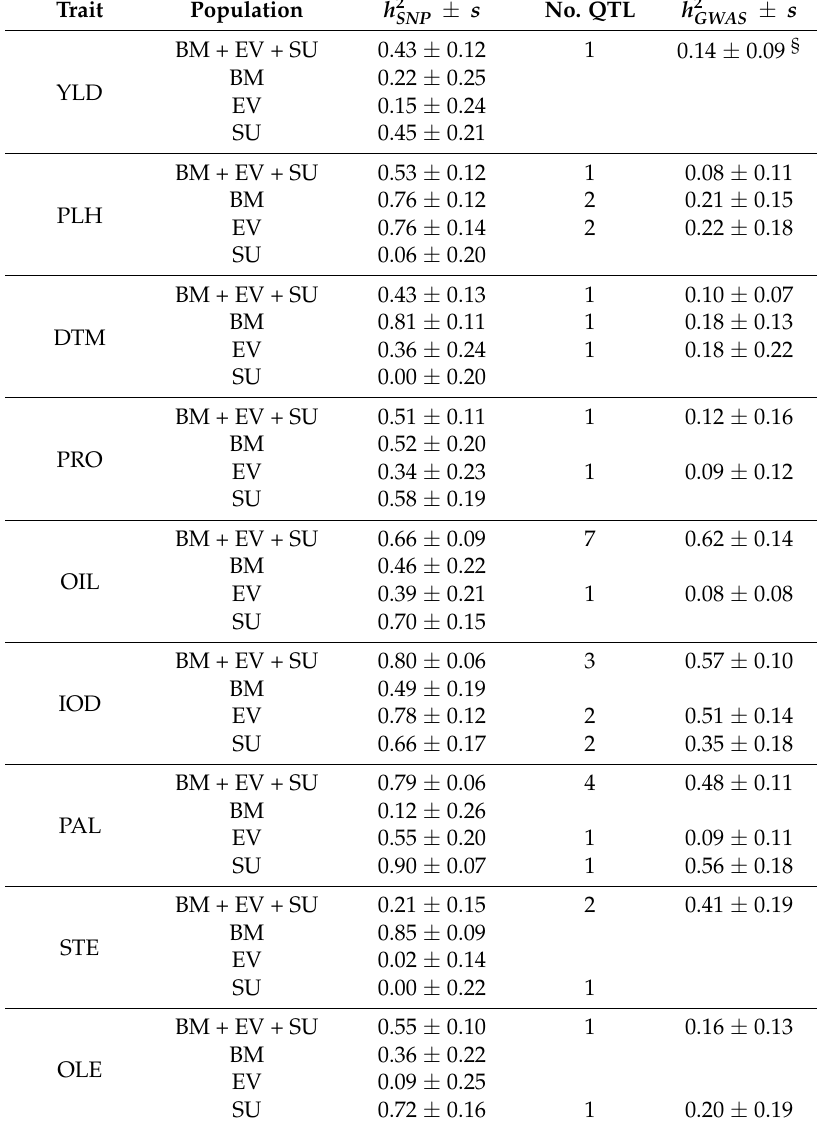
Table 2. Phenotypic variation explained by all SNPs ( h 2 different